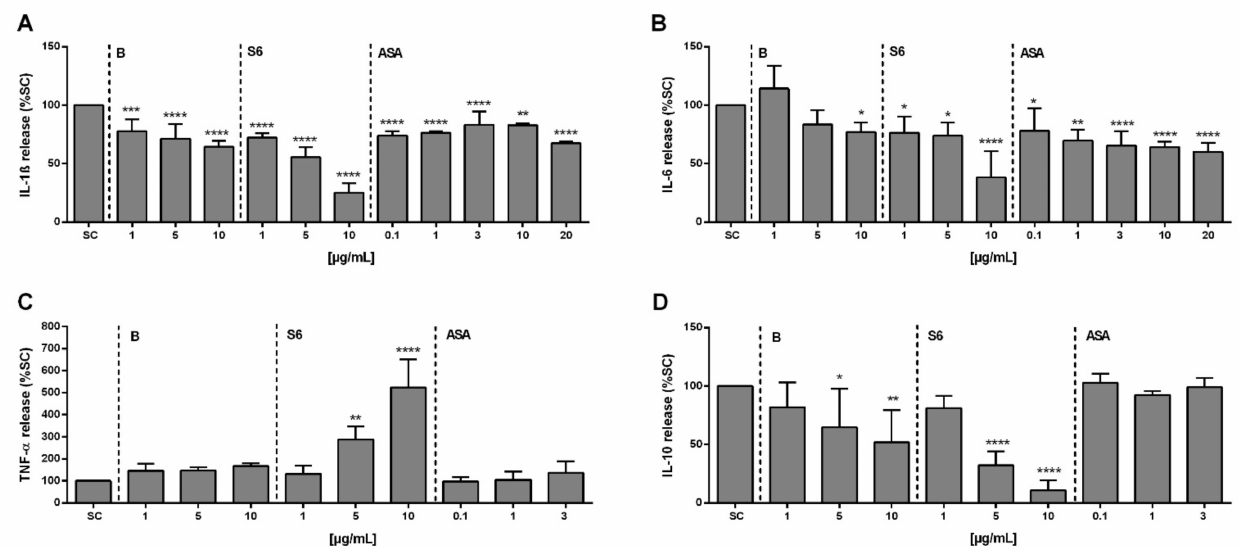
Figure 3. The effects of Salix extracts and ASA on the inhibition of cytokine secretion from SARS-CoV-2 peptide/IL-1 β - stimulated PBMCs. Cells (1 × 10 6 cells/mL) were pre-treated with Salix extracts or ASA for 30 min before stimulation for 6 h (TNF- α detection) or 24 h (interleukins). The amount of ( A ) IL-1 β , ( B ) IL-6, ( C ) TNF- α , and ( D ) IL-10 in the cell supernatant was measured using the ELISA technique. SC: 1% distilled water in activated cells. Bars are the means ± SD ( n ≥ 3). * p < 0.05, ** p < 0.01, *** p < 0.001, or **** p < 0.0001 versus SC